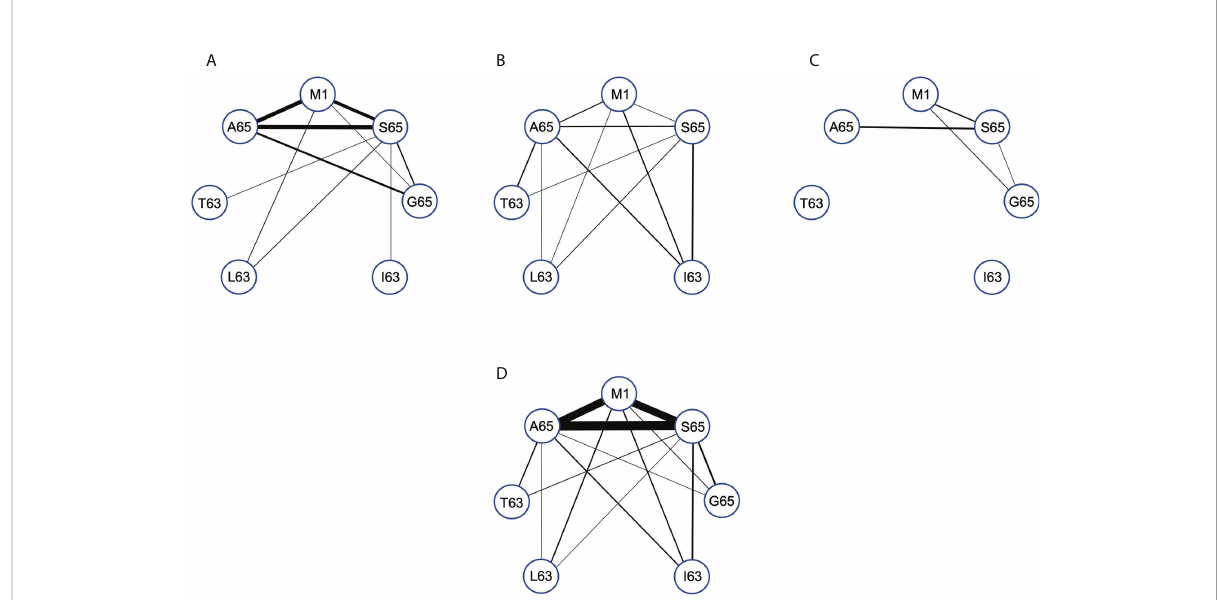
FIGURE 6 Pair-wise comparison of repertoire connectivity for the M1, A65, and S65 repertoires. The thickness of each connection also re fl ects this number. (A – C) Represent the connectivity for Donors (A – C) respectively. (D) Is the combined connectivity for all repertoires. Connectivity values are given in Supplemental Table